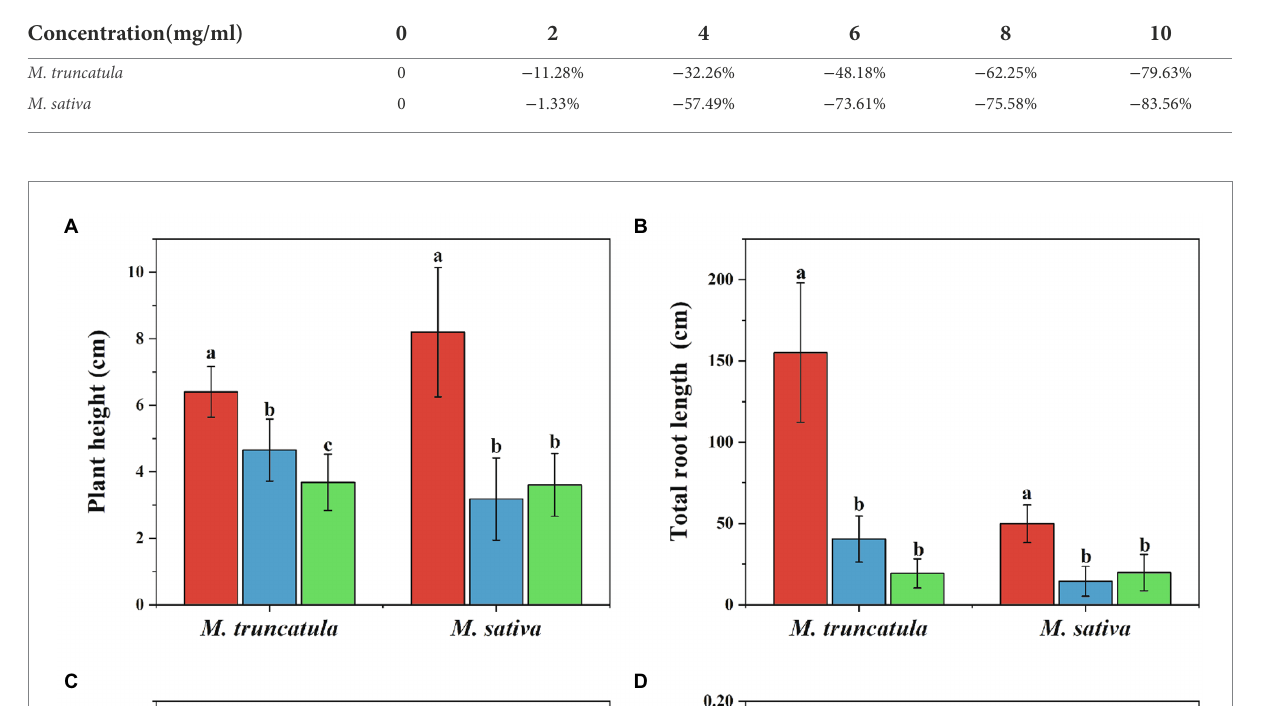
TABLE 2 Effects of alfalfa extracts on synthetic allelopathic effect index (SE).